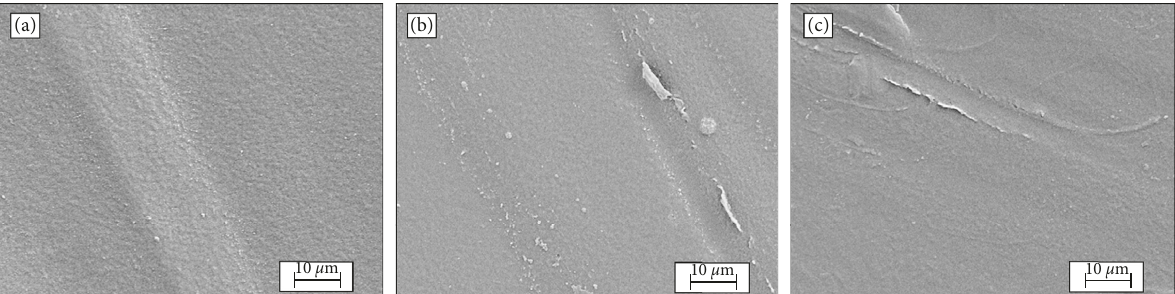
Figure 3: Field-emission scanning electron microscopy of polyurethane films sputter coated with gold at (a) 0 Gy · min − 1 , control (b) 3.2 Gy · min − 1 , and (c) 833 Gy · min − 1 dose rates. Scale bars represent 10 µ m.